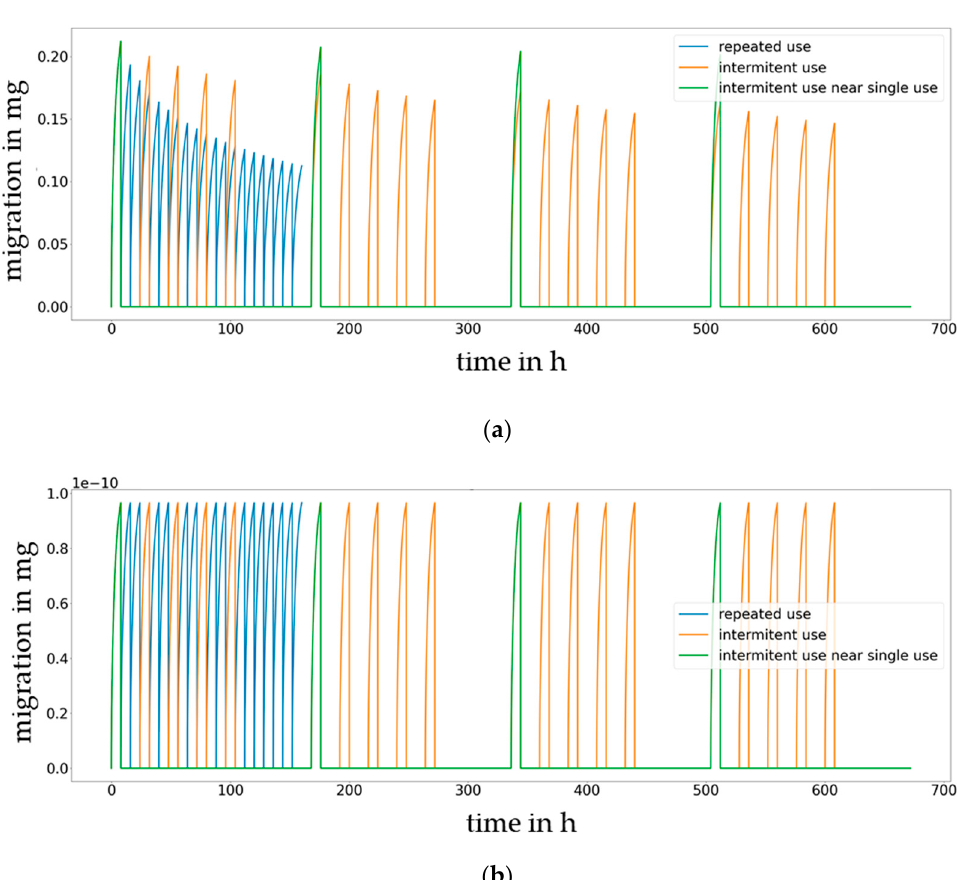
Figure 12. Comparison of repeated-use scenarios (blue: continuous use, orange: intermittent use 8 h contact and 16 h without contact and green: occasionally use). Migration of Metilox ( a ) and Irganox 1076 ( b ) to 50% ethanol (K = 10) at 60 °C.